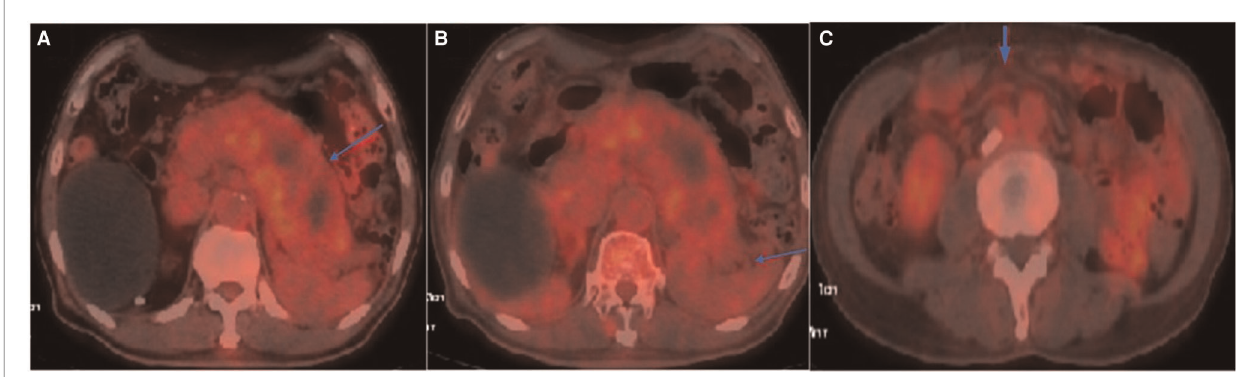
FIGURE 1 | Axial view of FDG-PET/CT: ( A ) Hypermetabolic activity in the swollen pancreas with SUV max of 3.0; ( B ) Mild hypermetabolic activity surrounding the pancreas; ( C ) Mild hypermetabolic activity in the mesenteric area with SUV max of